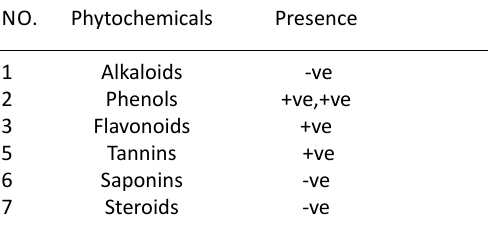
Table 1. The presence of different phytochemicals in the P.granatum L. peel extract and it’s observed that the absence of steroids and saponins and the presence of phenols, Alkaloids, Flavonoids and Tanins NO